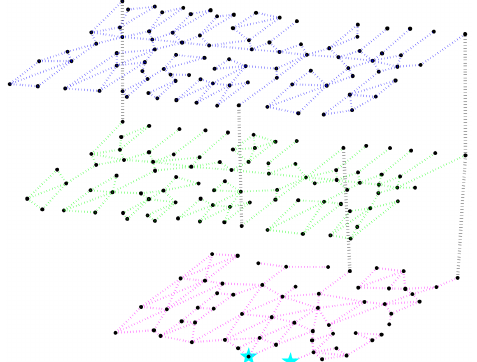
Figure 2. Graph representation of the building model [14]. The two cyan stars on the ground floor mark the position of the building’s